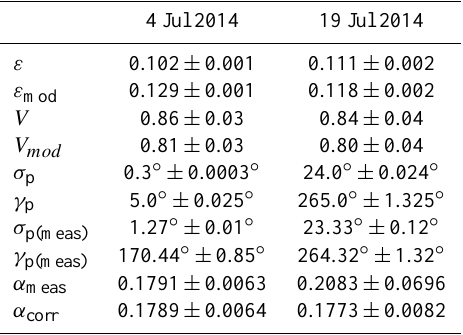
Table 3. Results of measured and corrected inclinations and direc- tions and daily average albedo, including all standard deviations, at the AWS sites Kleinfleißkees on 5 March 2011 and Goldbergkees on 27 June